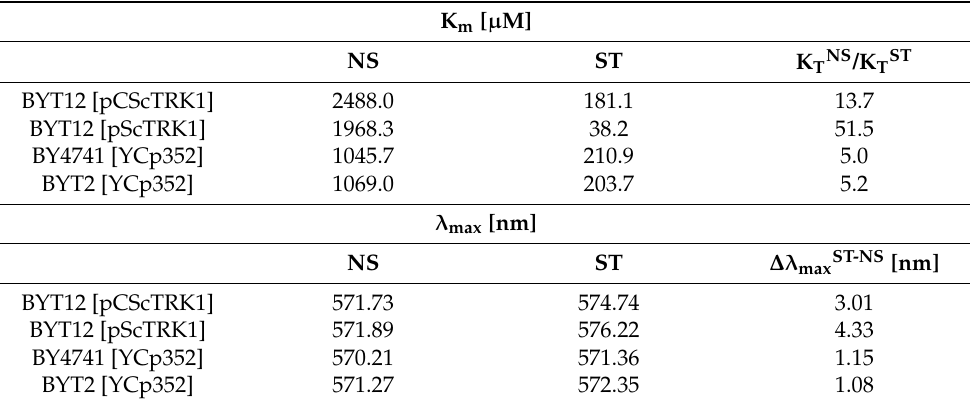
Table 2. Correlation of changes in kinetic parameters and relative membrane potential upon 1 h of K +